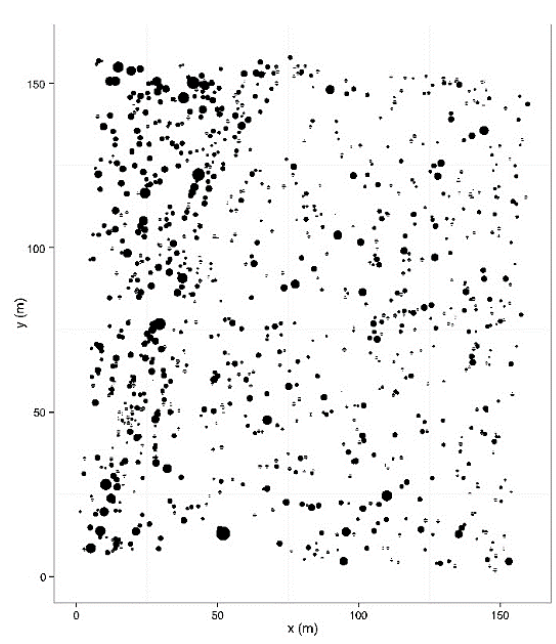
Figure 4. Map of the study area showing the spatial distribution of eshnan shrubs (n = 989) with different sizes based on their crown